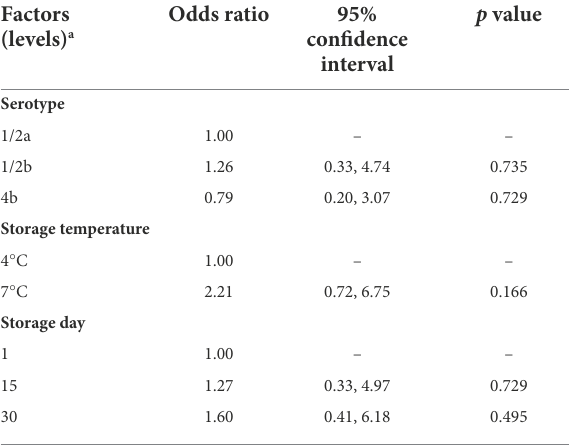
TABLE 2 Odds ratios and 95% confidence intervals (CIs) with respect to factors associated with the complete elimination of Listeria monocytogenes on cold-smoked salmon samples due to 250 ppm nisin